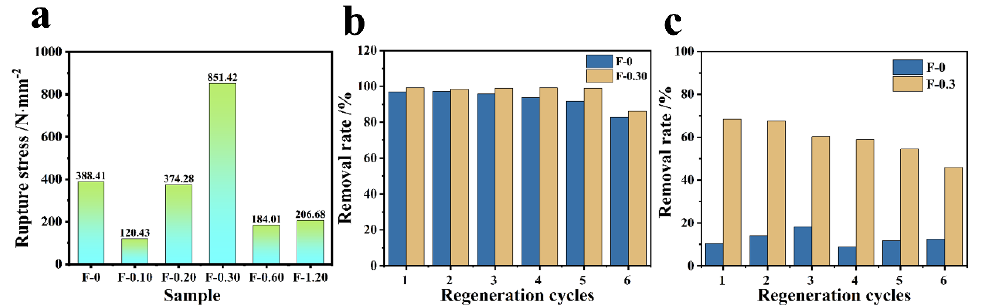
Figure 13. ( a ) The tensile ability test of the composite membrane. ( b ) The Cr (VI) adsorption cycle results of F-0 and F-0.3. Reaction conditions: Cr (VI) (40 mg/L, 60 mL), adsorbent (0.2 g), and reaction time (60 min). ( c ) The RhB adsorption cycle results of F-0 and F-0.3. Reaction conditions: RhB (40 mg/L, 60 mL), adsorbent (0.2 g), and reaction time (60 min).